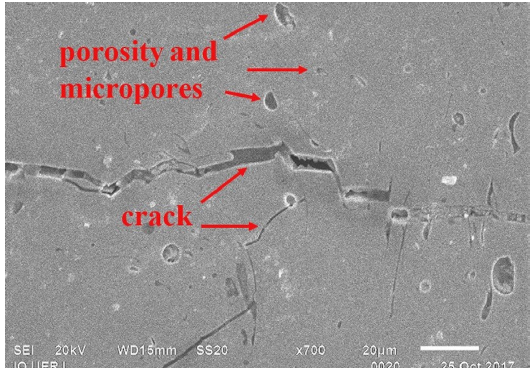
Figure 6. Coating cross-section. SEM, 700X. Cracks and pores (regions with more intense shades of gray) are defects typically associated with the spraying process